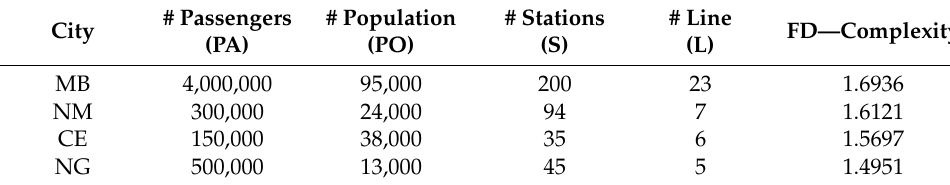
Figure 6 . Calculated and predicted complexity of the network . Figure 6. Calculated and predicted complexity of the network. Table 1. Parameters for modeling complexity of bus transport network.